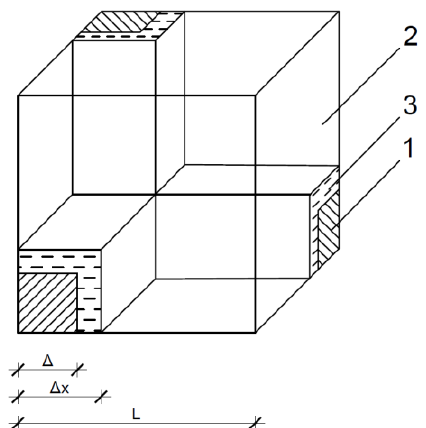
Figure 6. The eighth part of the unit cell with a continuous liquid inclusion.